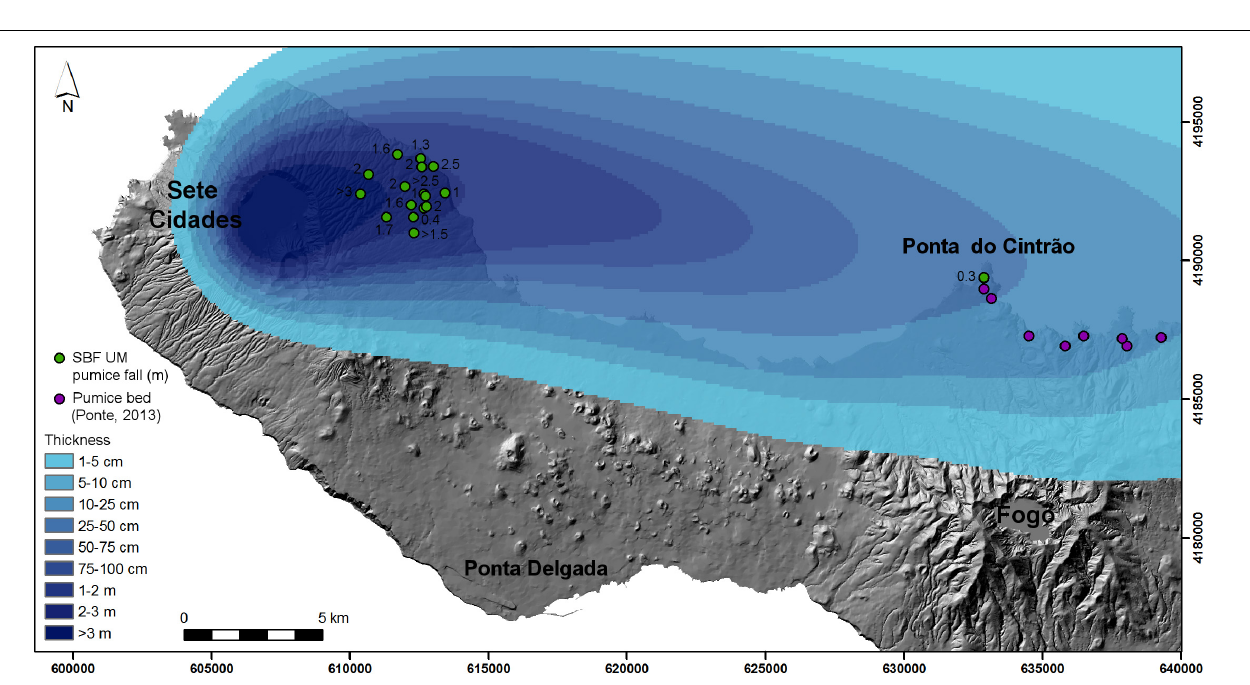
FIGURE 6 | Scenario 1 tephra fall map resulting from the simulations with VORIS 2.0.1, reconstructing the thickness of the proximal pumice fall deposit of the Upper Member of the SBF. Strong and unidirectional winds are interpreted to limit the dispersal and deposition to a narrow sector.